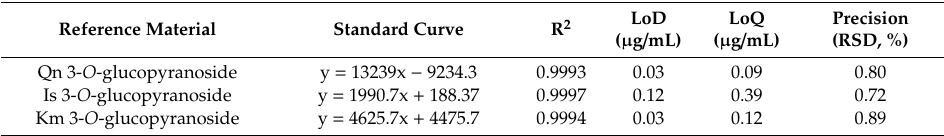
Table 4. Quantitative performance of the polyphenolic reference materials used in this study using the RP-LC × RP-LC system coupled to PDA detection.